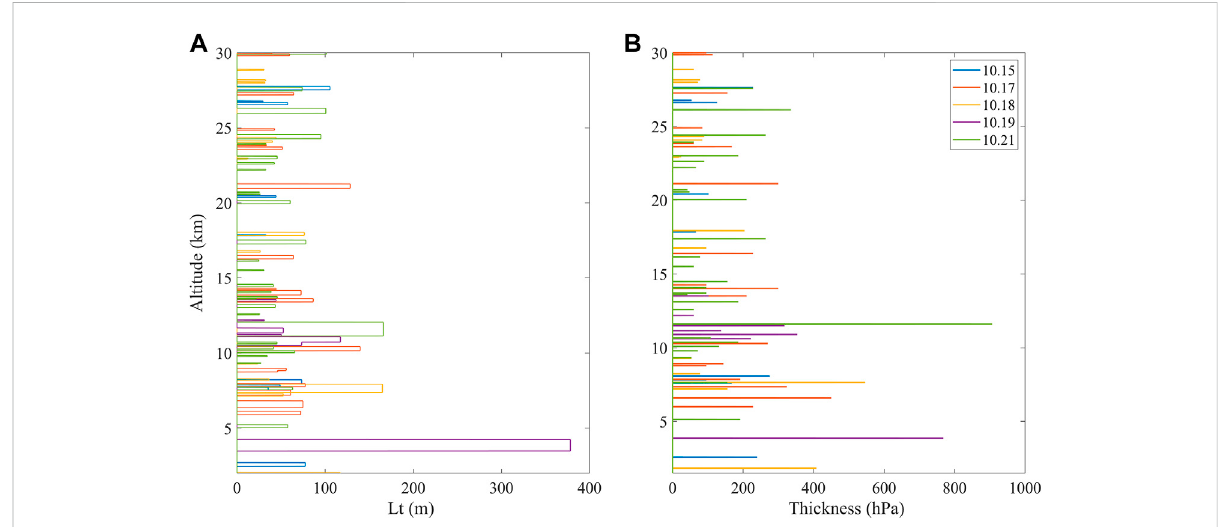
FIGURE 4 Distributions of the (A) Thorpe scale and (B) thickness of the turbulence layer from October 15 to 21,